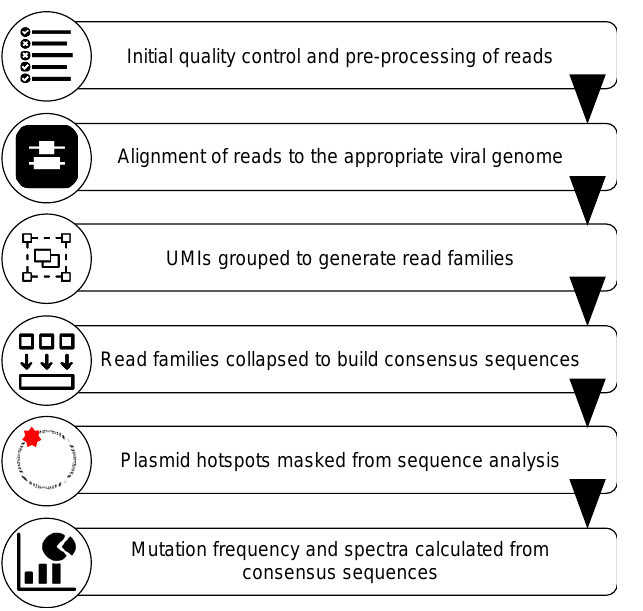
Figure 2. An overview of the pipeline developed for analysis of the MDS sequencing data. See text for details.